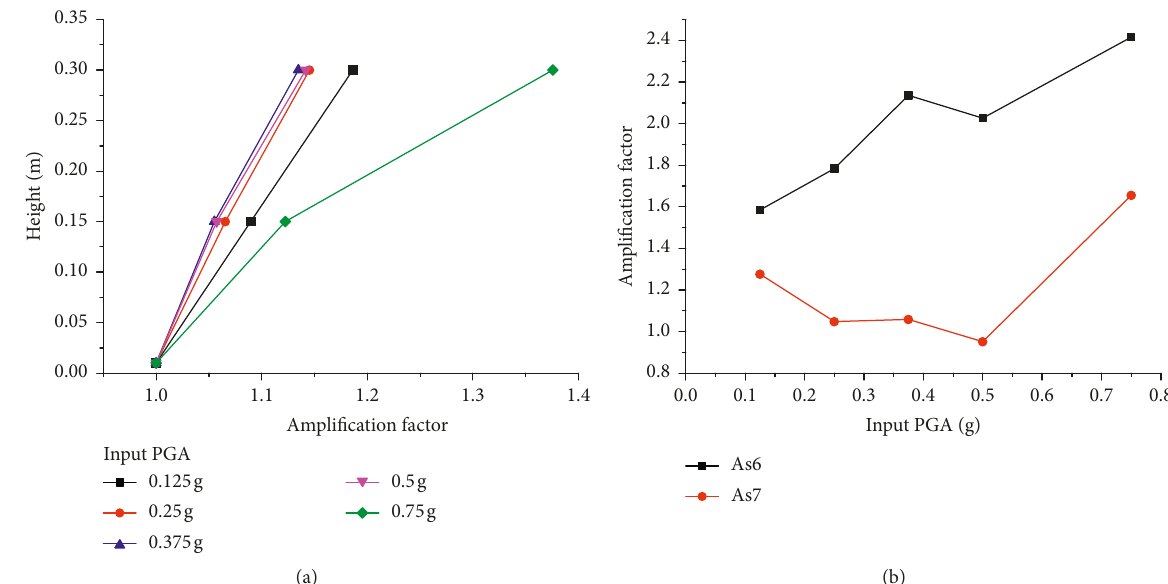
Figure 12: Acceleration amplification factor of the structure: (a) model tunnel and (b) pipelines hold by the